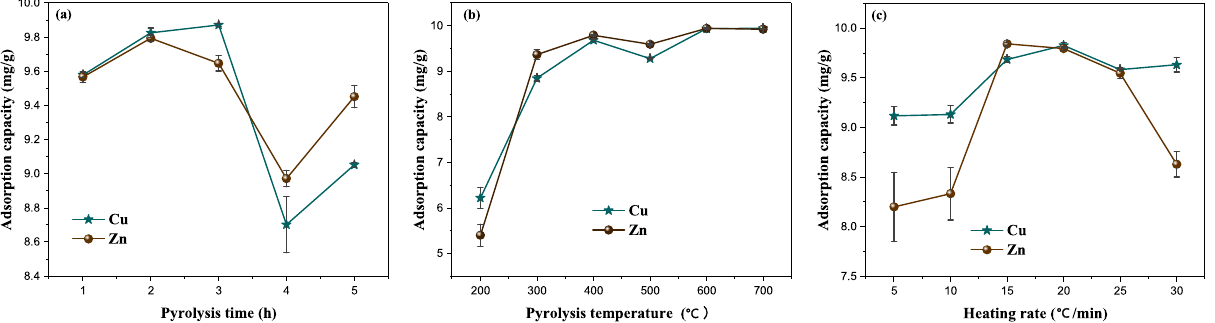
Figure 1. Effects of pyrolysis conditions on the adsorption capacity of Cu 2+ and Zn 2+ by BC.